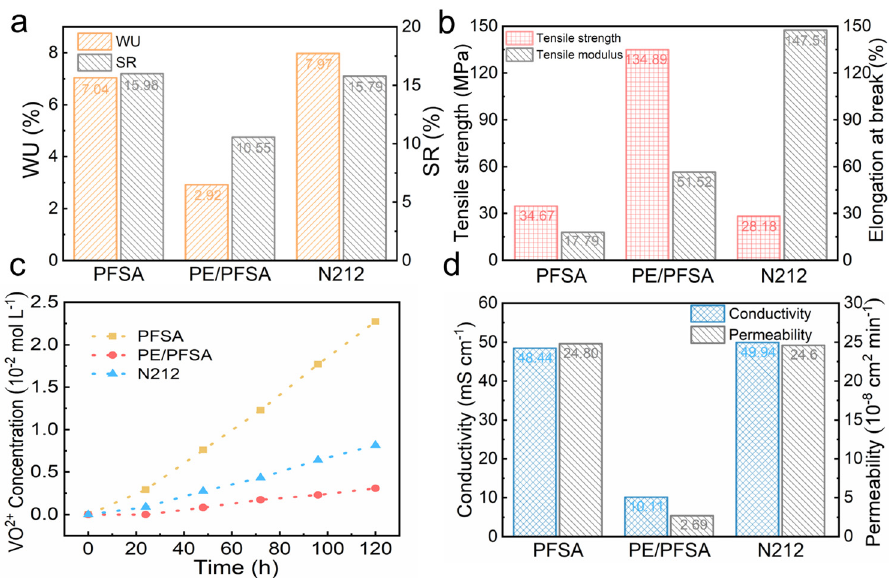
Figure 4. ( a ) Dimensional stability parameters, ( b ) mechanical performance parameters, ( c ) VO 2+ concentration curve over time, and ( d ) proton conductivities and vanadium ion permeabilities of the membranes.